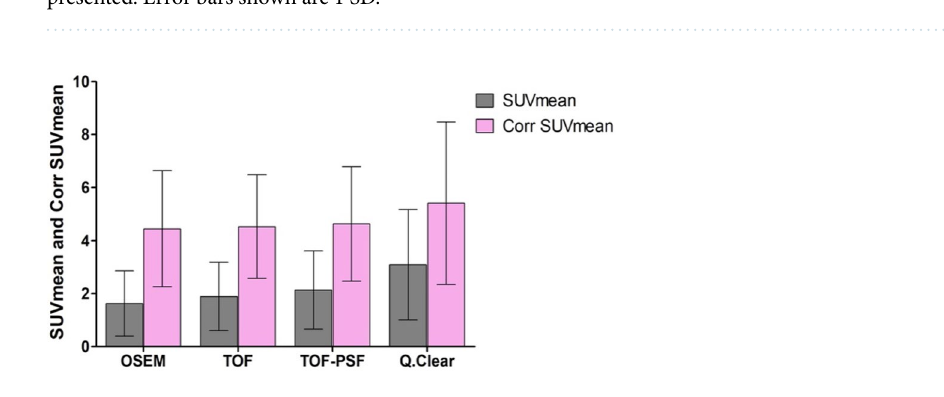
Figure 6. The histogram plots of SUVmean and PVE corrected SUVmean (corr SUVmean) of 75 pulmonary nodules on PET images reconstructed with different methods. After the PVE correction, the SUVmean increases represented by % △ SUVmean were 160.1%, 138.4%, 116.4%, and 75.1% for OSEM, TOF, TOF-PSF and Q.Clear,